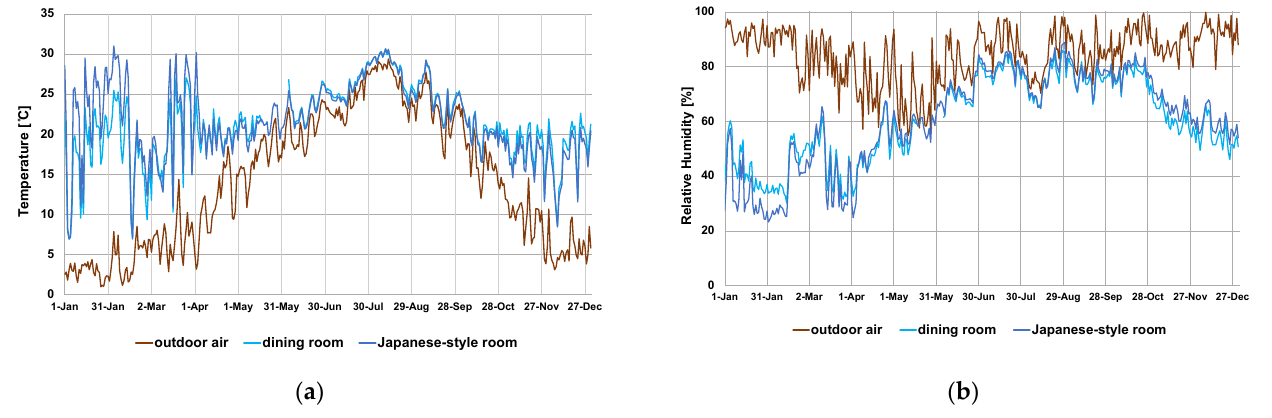
Figure 3. Daily mean ( a ) temperature (°C) and ( b ) relative humidity (%) in 2019. Outdoor air and indoor air (dining room and Japanese-style room) data are shown in this graph.